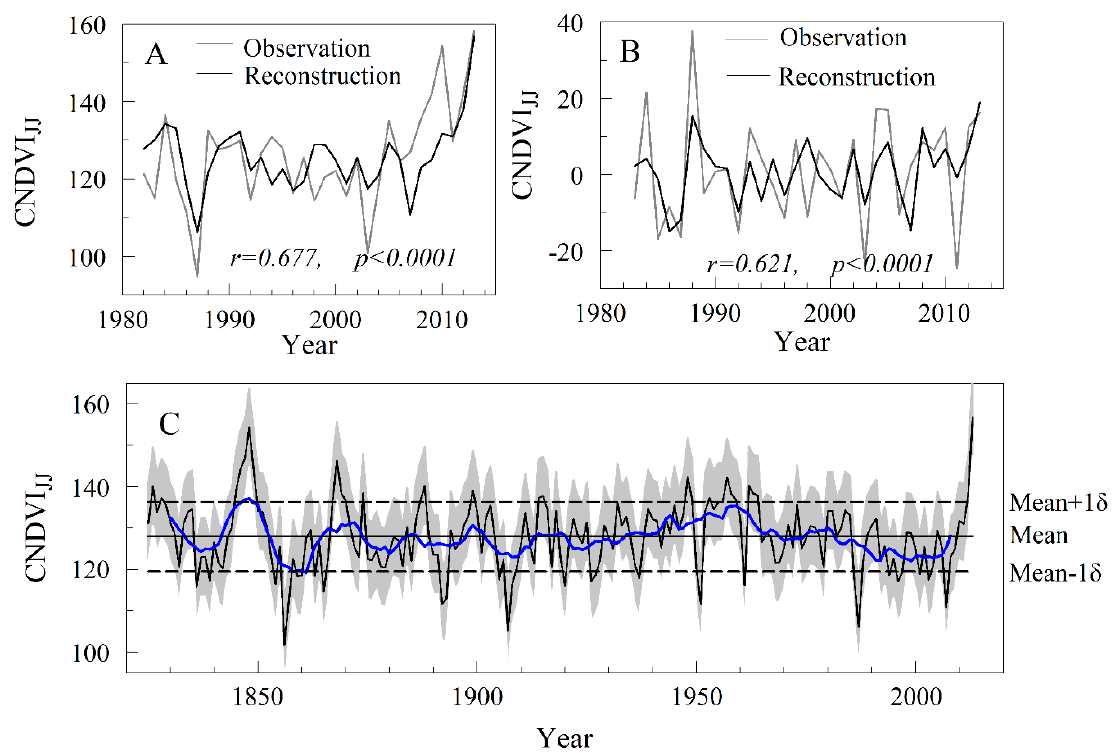
Figure 6. CNDVI JJ reconstruction for the CW–DHM region during the period 1825 to 2013 CE: ( A ) comparison between the original observed and reconstructed CNDVI JJ during the period 1982 to 2013 CE; ( B ) first-order difference of A; ( C ) The reconstructed CNDVI JJ from 1825 to 2013 CE. The black line represents the reconstructed series, and the blue line represents an 11 y moving average. The grey area denotes ± one RMSE (root mean square error) of this reconstruction.